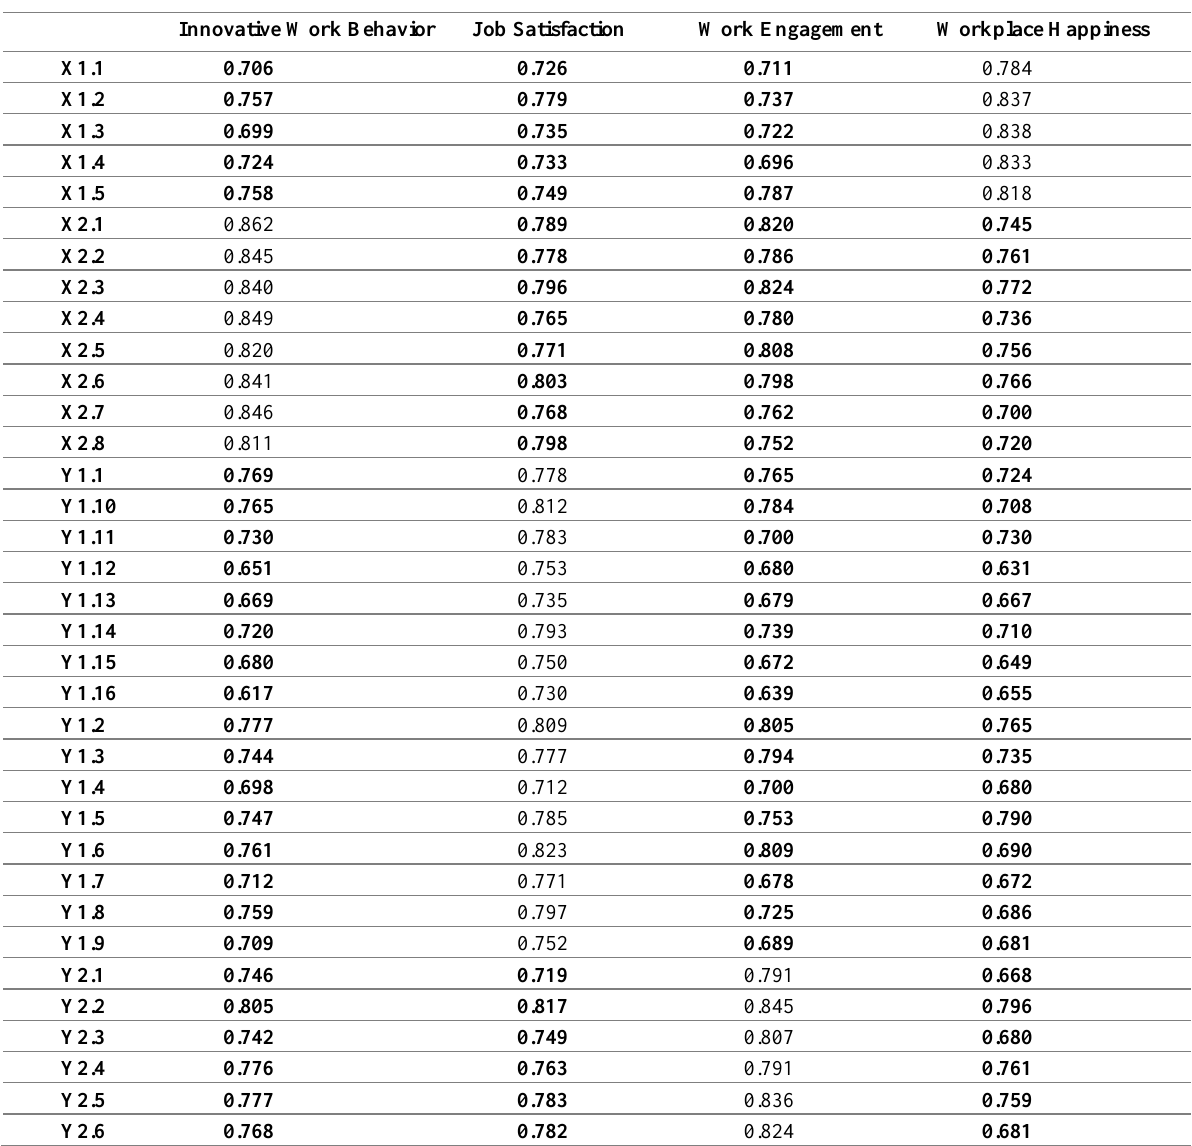
Table 3: Cross Loading Value